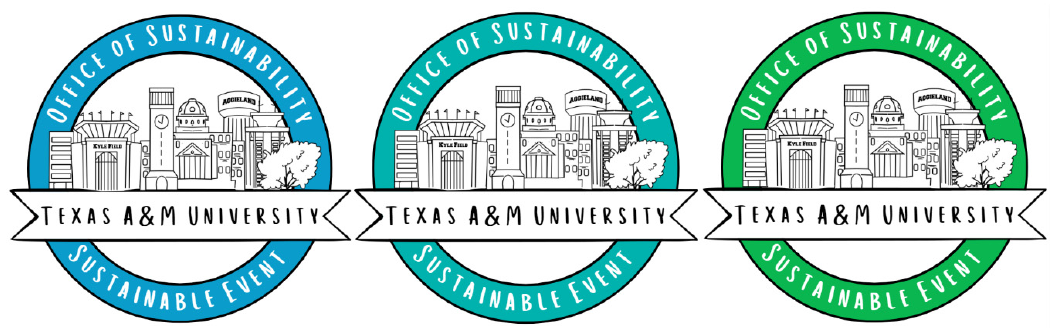
Figure 5. Current SEC icons based on tier certified (Supporter, Advocate, and